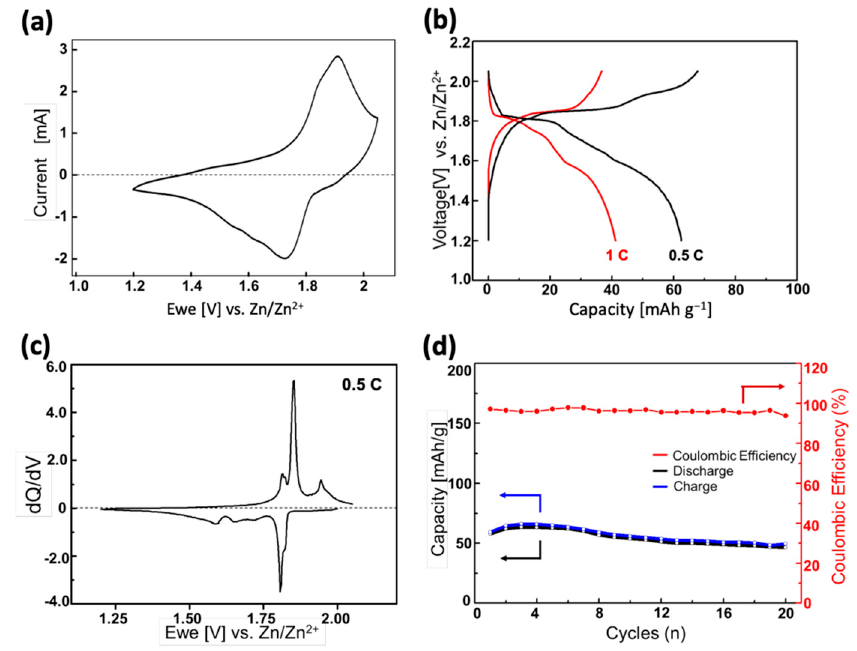
Figure 3. ( a ) Cyclic voltammograms of the ZPB electrode at 1 mV s − 1 with zinc metal as the counter and reference electrode in 0.1 M ZnSO 4 aqueous electrolyte; ( b ) initial discharge-charge cycles at various C rates; ( c ) dQ/dV curves corresponding to the profiles in ( b ); ( d ) cycling performance at 0.5 C rate.